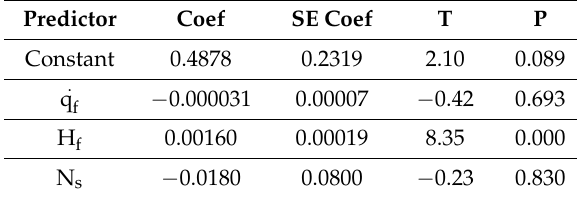
Table 9. Regression equation coefficients.